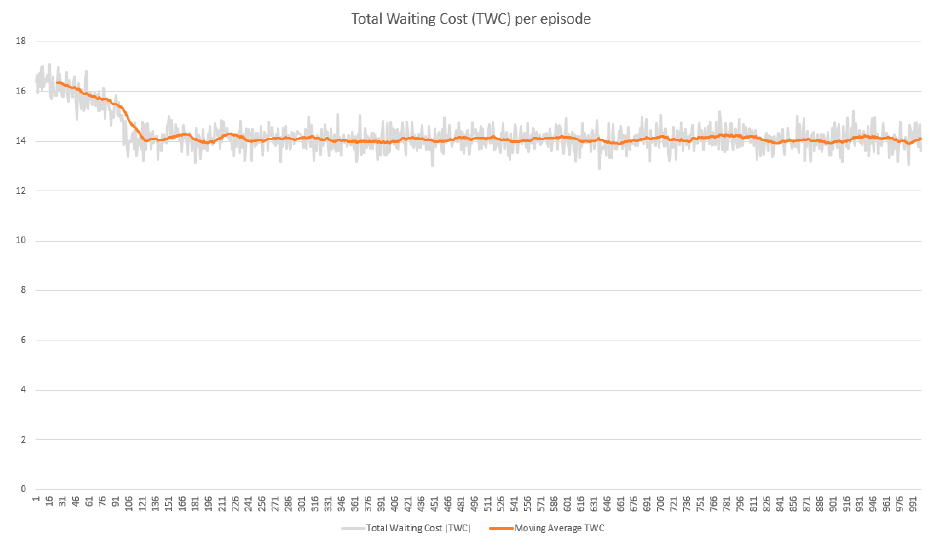
Figure 12. Truck waiting cost (TWC) per episode. In the testing phase, we ran the DQN and the two baseline algorithms 30 times for Table 9. Performance comparison between DQN and SA.